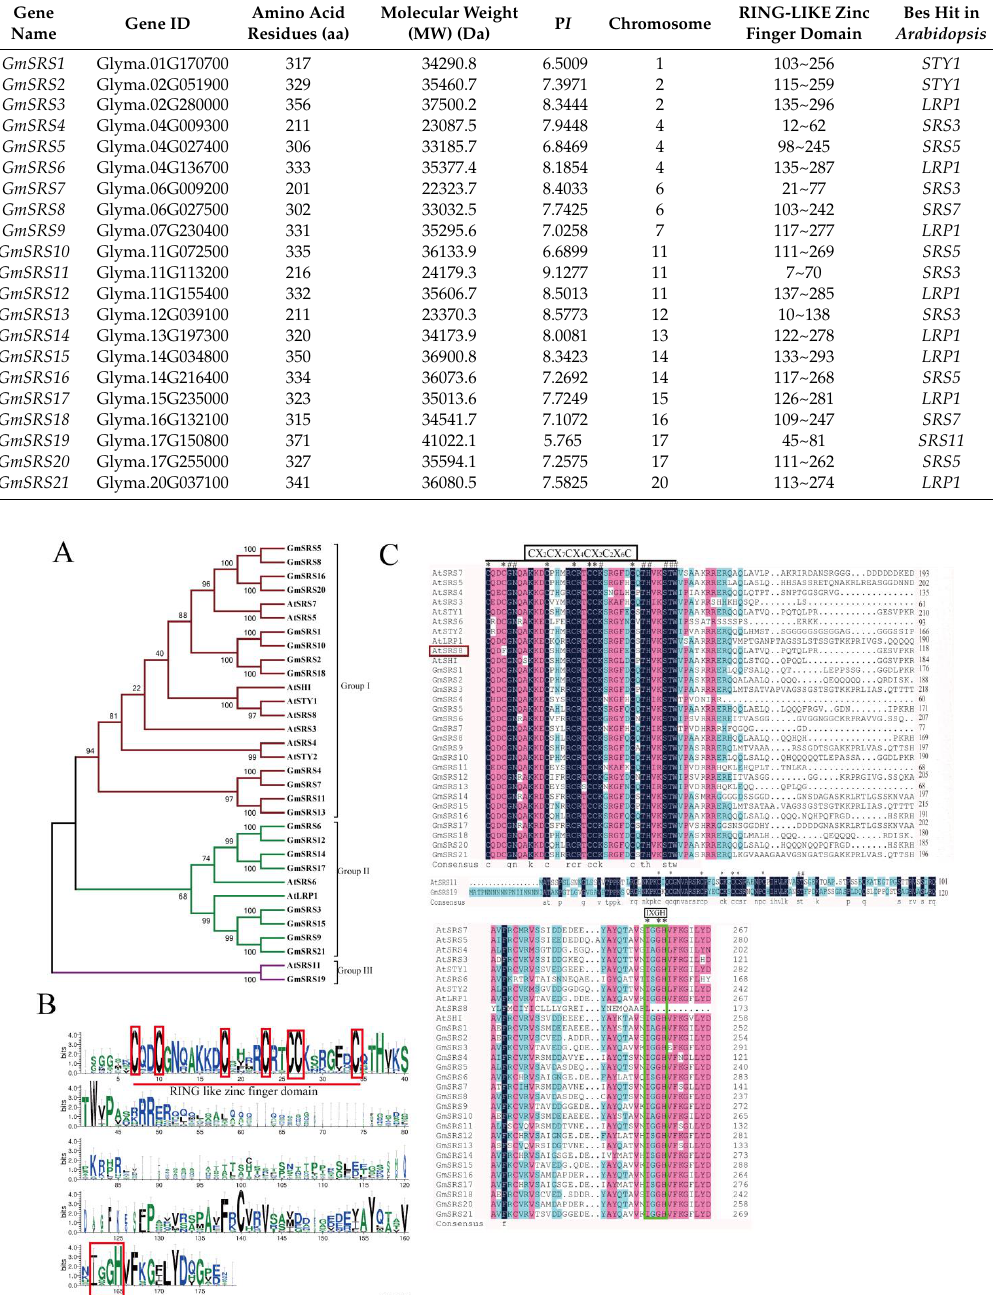
Table 1. The characteristic information of the SHI-RELATED SEQUENCE (SRS) transcription factors.